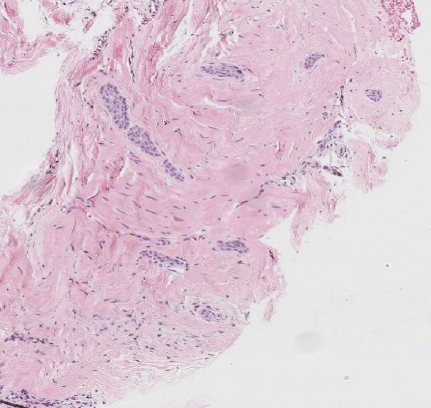
Figure 3: Micrograph of the needle core biopsy, presenting elon- gatedepithelialislandscomposedofcubiccellswithasmallcentrally located lumen of cuticles, surrounded by fibrous